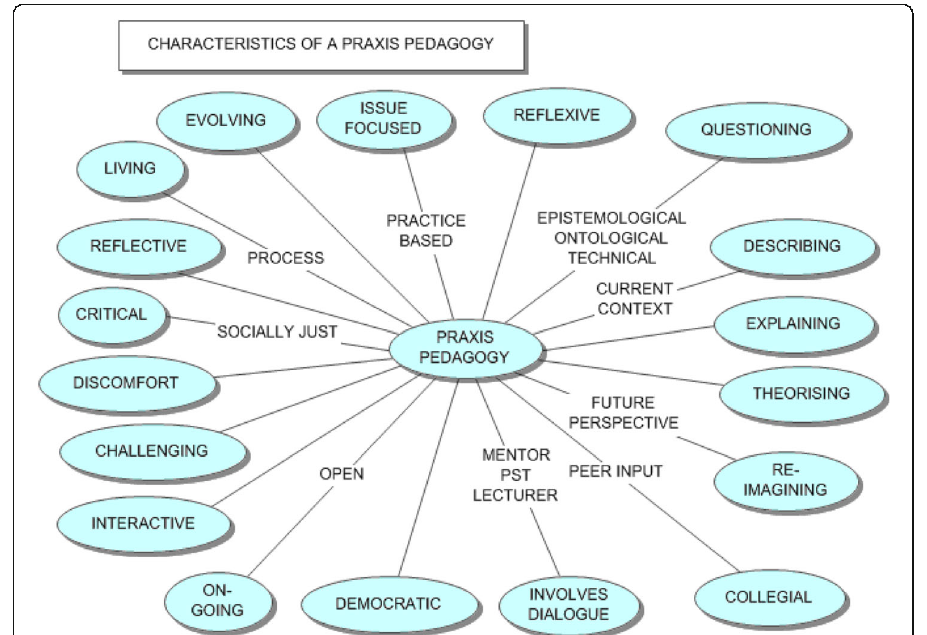
Fig. 1 Characteristics of Praxis Pedagogy